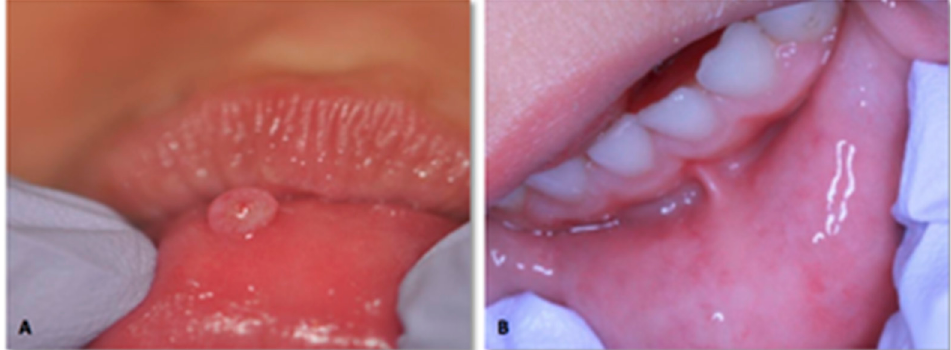
Figure 3. Laser removal of mucocele of the lower lip in a four years old male. ( A ) Initial clinical presentation ( B ) Clinical appearance after one month.